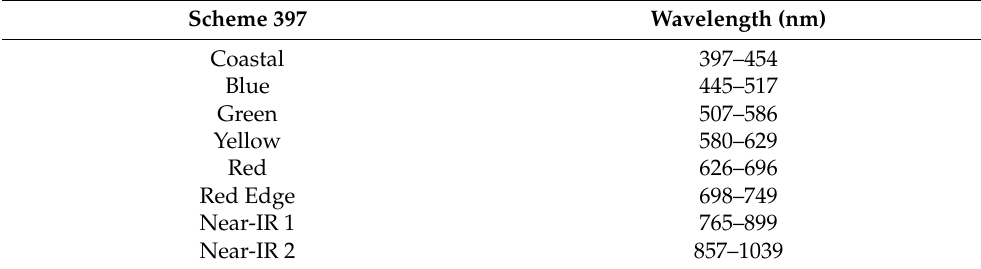
Table 1. WorldView-2’s eight multispectral